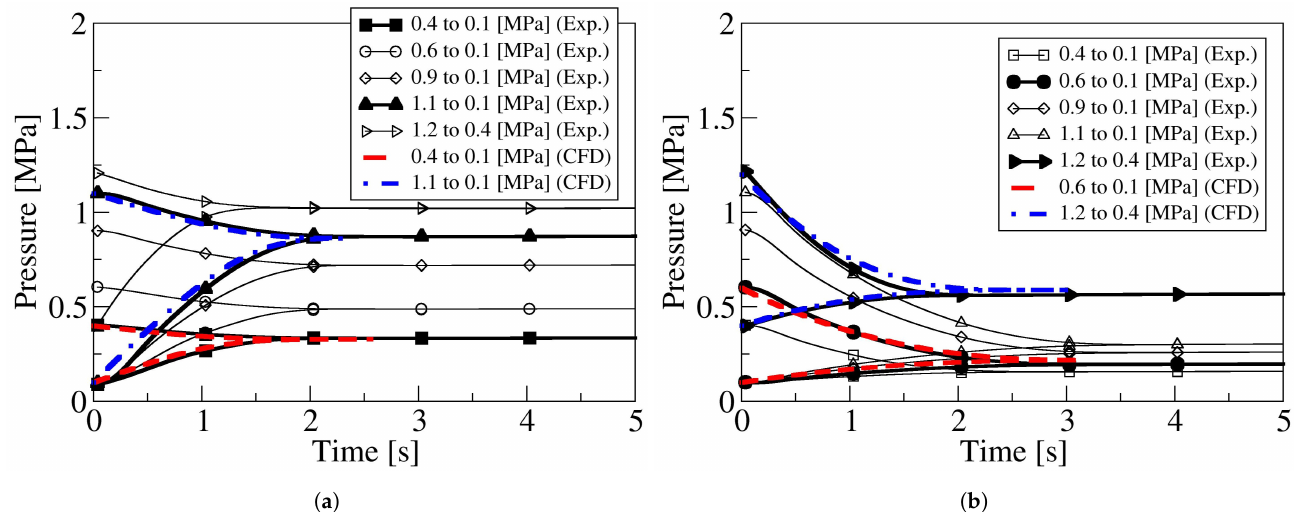
Figure 4. Measured temporal pressure variation in both reservoirs, comparison between experimental and CFD results. ( a ) Flow from large to small reservoir. ( b ) Flow from small to large reservoir. Five different pressure decays are considered for each flow direction; see Table 1.